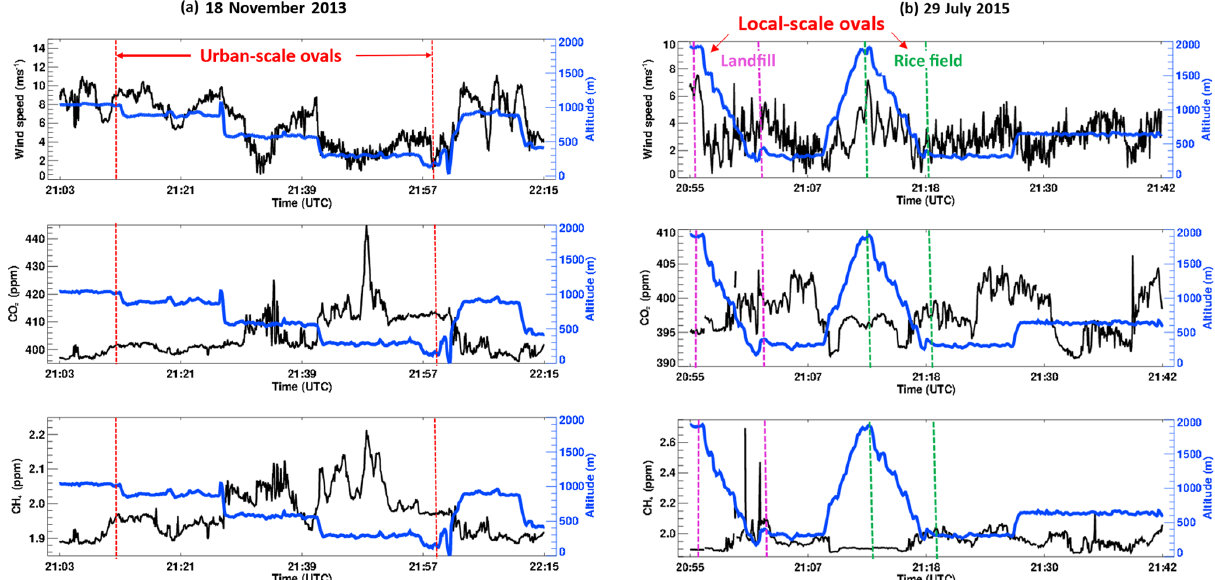
Figure 2. (a) A time series of (black lines) CO 2 , CH 4 , horizontal wind speed, and (blue lines) altitude of the aircraft for 18 November 2013. The red dashed lines represent the portion of the flight over Sacramento. (b) The same as Fig. 2a except for 29 July 2015. The magenta dashed lines indicate the portion of the flight over the landfill, and the green dashed lines mark the start and end times of the rice field measurements.